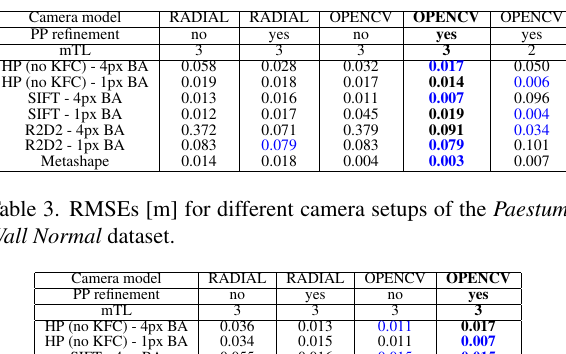
Table 2. RMSEs [m] for different camera setups of the Ven- timiglia Theatre Nadiral+Oblique dataset.